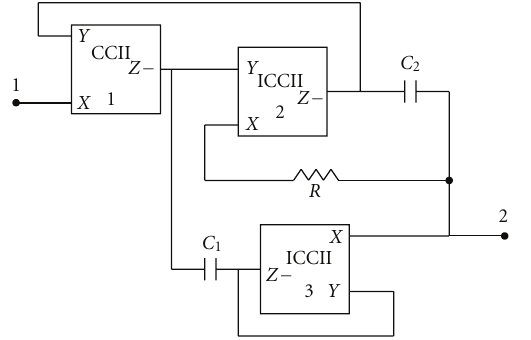
Figure 8: Floating FDNR realization using one CCII − and two ICCII −